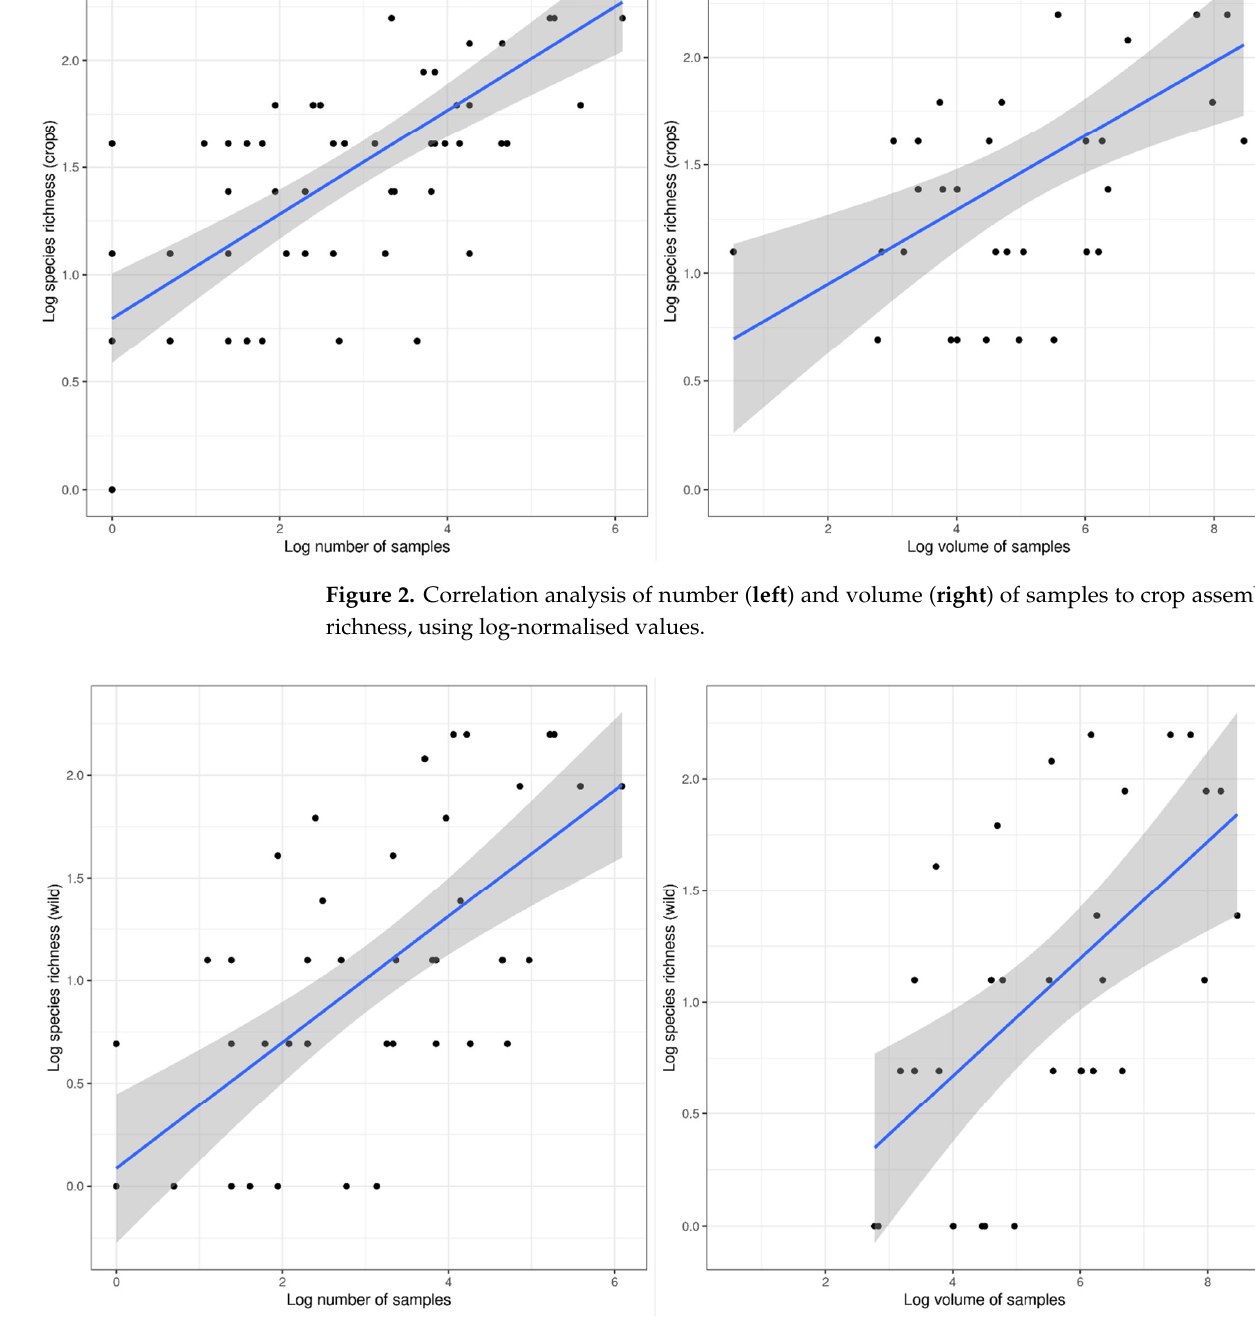
Figure 4. Sampling intensity by archaeological culture.